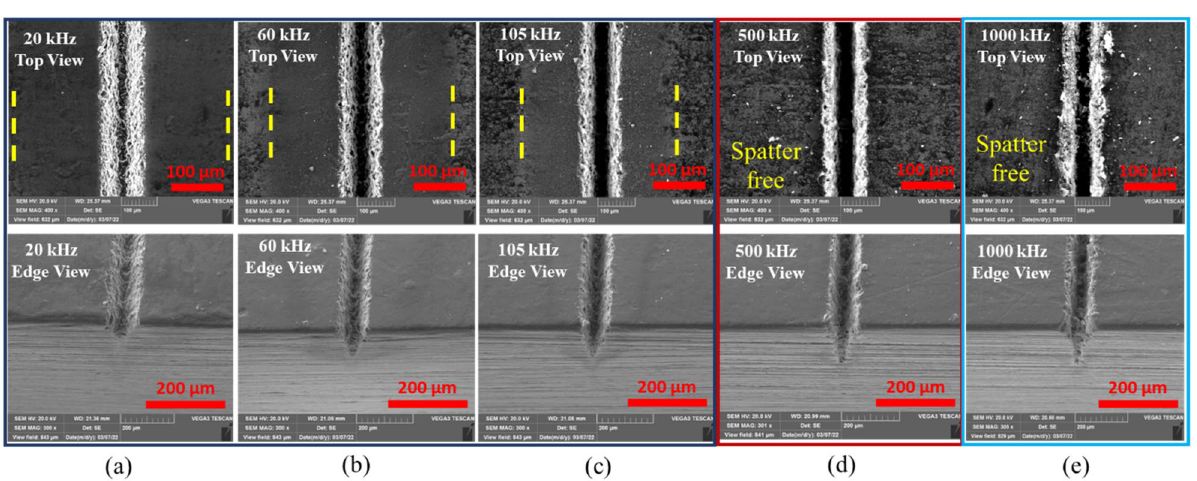
Figure 13. Effect of repetition rate and pulse duration; ( a ) on penetration depth, ( b ) on top width, [Fixed: 20W, 100 mm/s, 1 pass].